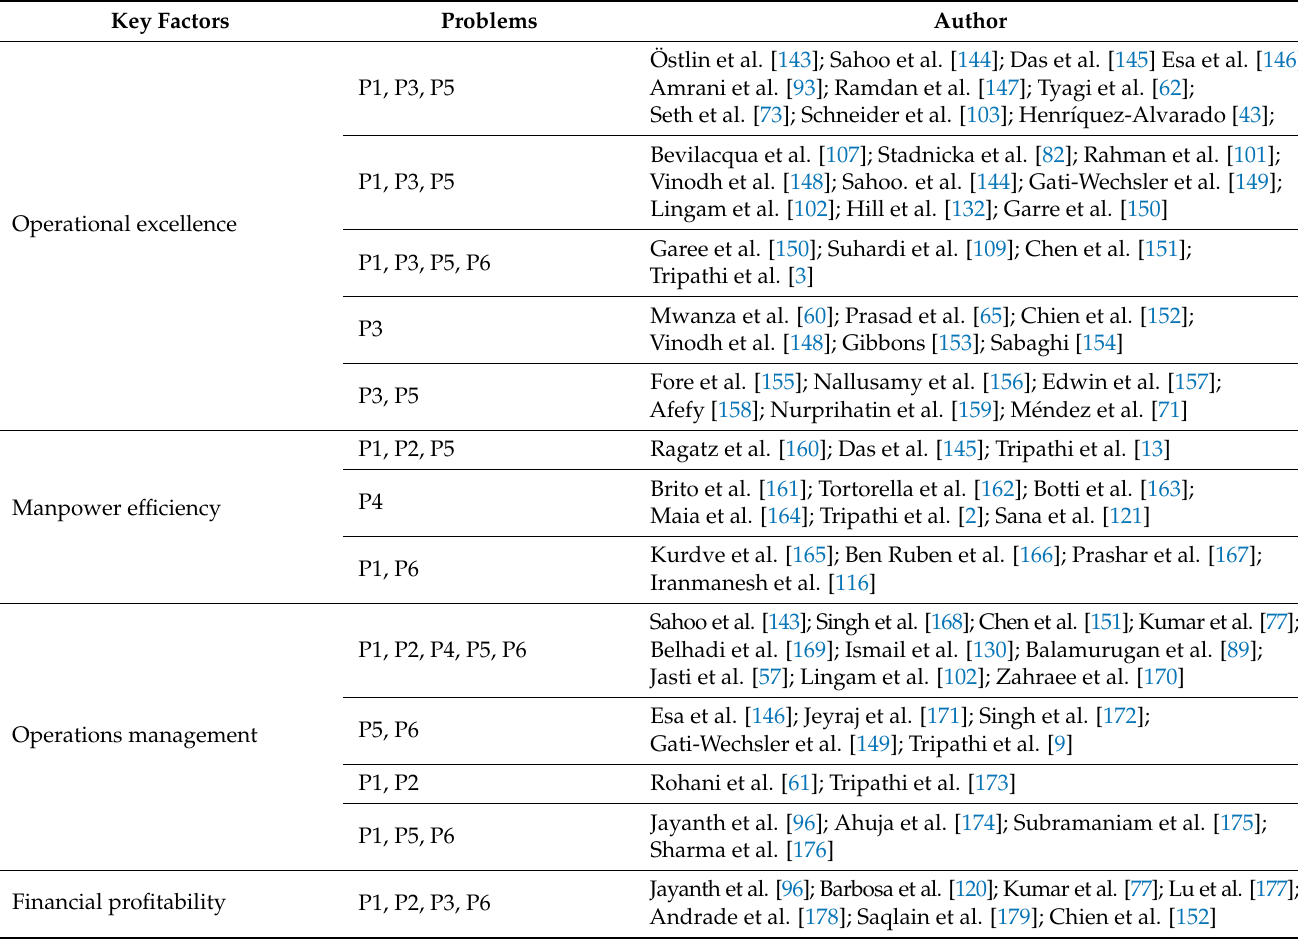
Table 3. Illustration of key factors and issues in shop floor